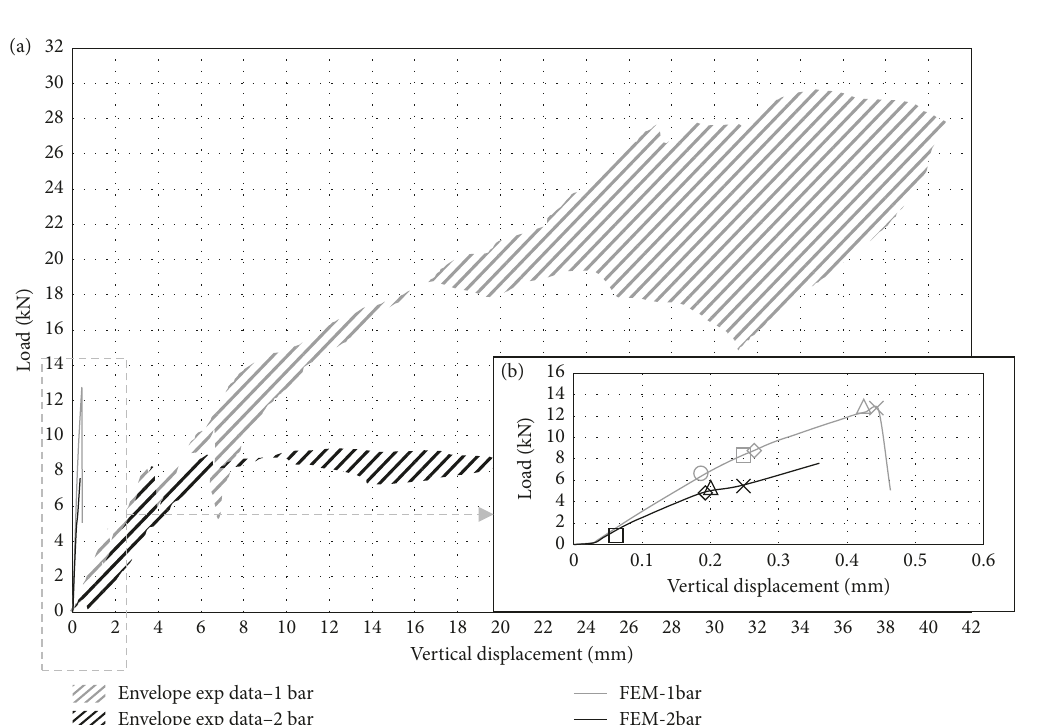
Figure 11: (a) Load-displacement graphs of FE analyses compared to the experimental data envelopes and (b) detailed graph of the two FE analyses, with indications of bar plasticization (circle), mortar cracking (square), brick cracking (lozenge), mortar crushing (triangle), and brick crushing